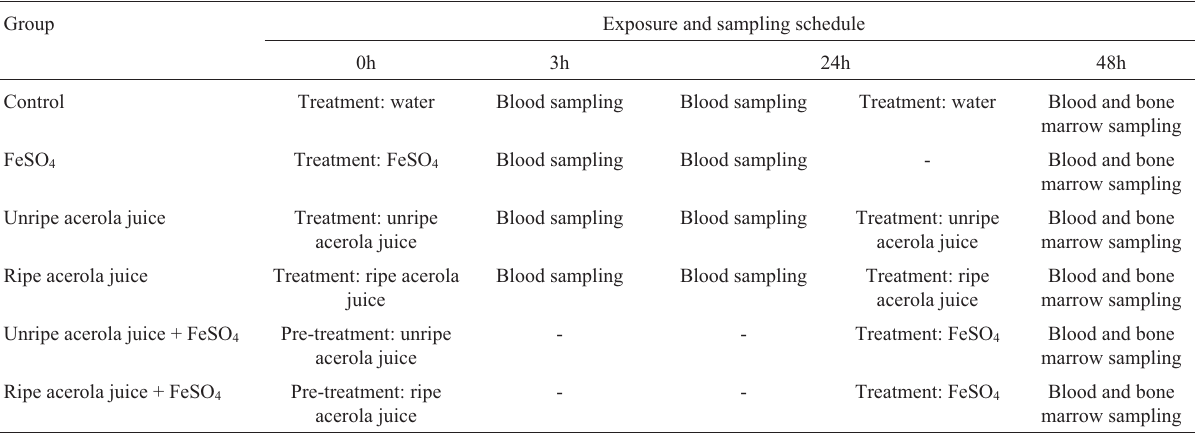
Table 1 - Experimental procedures: treatment protocols and blood sampling schedules. Group Exposure and sampling schedule